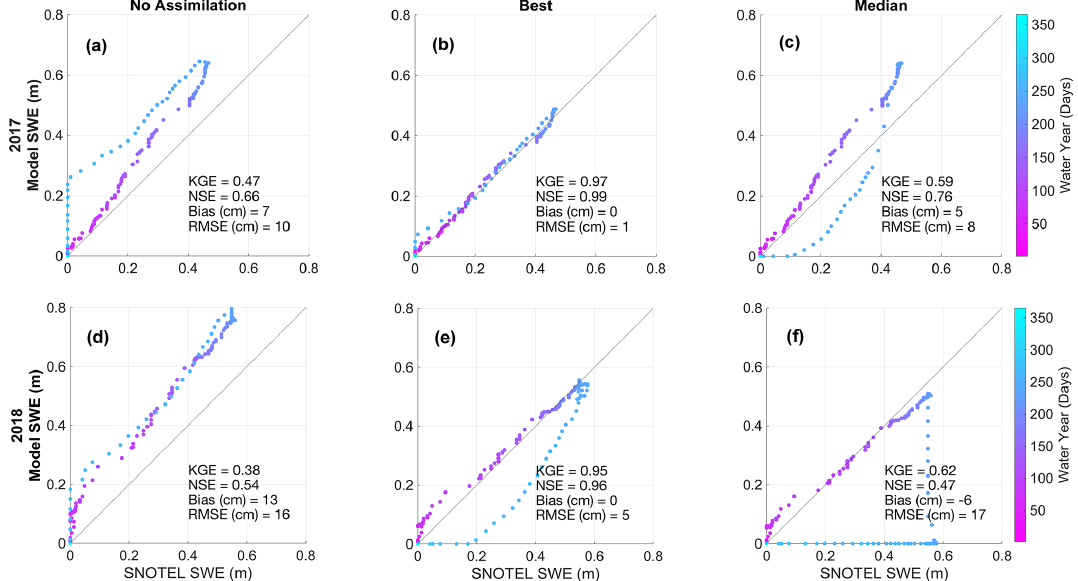
Figure 4. Time series at Upper Tsaina SNOTEL station. The Upper Tsaina SNOTEL snow water equivalent (SWE) observations versus the modeled SWE for the no assimilation case (a, d) , the best CSO simulation (b, e) , and the median CSO simulation (c, f) . The time series color gradient corresponds to the day of the water